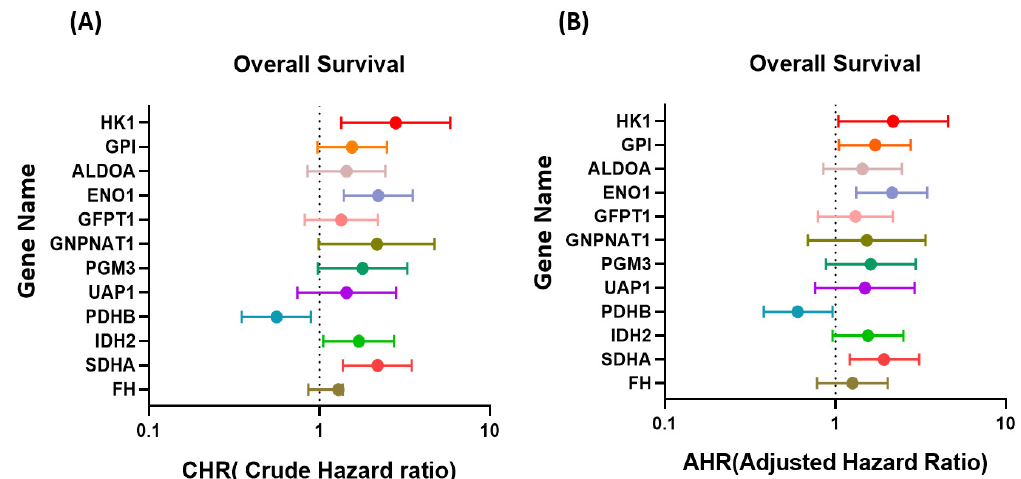
Figure 7. Correlation between overall survival and glycolysis-, HBP-, and TCA cycle-related enzymes was examined using data from the TCGA database. ( A ) CHR (crude hazard ratio) and ( B ) AHR (adjusted hazard ratio). The filled circle indicated the Crude or Adjusted hazard ratios of individual genes.